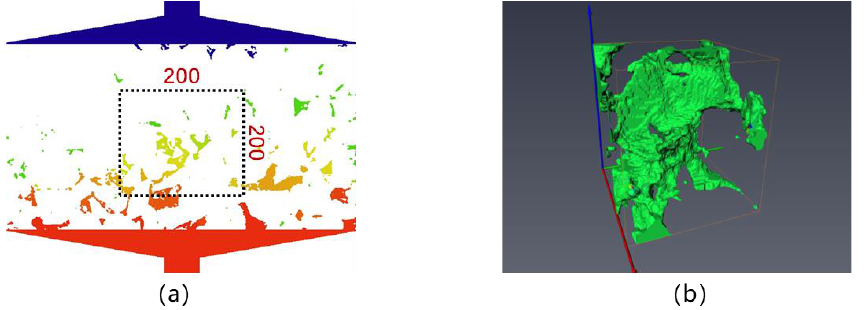
Figure 10. Cross section of the pressure field of REV1 with a square bounded by black dash lines, indicating the scope of a tighter 200 × 200 × 200 voxels REV to be extracted ( a ) and the pore structure( b ) of it denoted in green bounded by a cube as the computational domain.